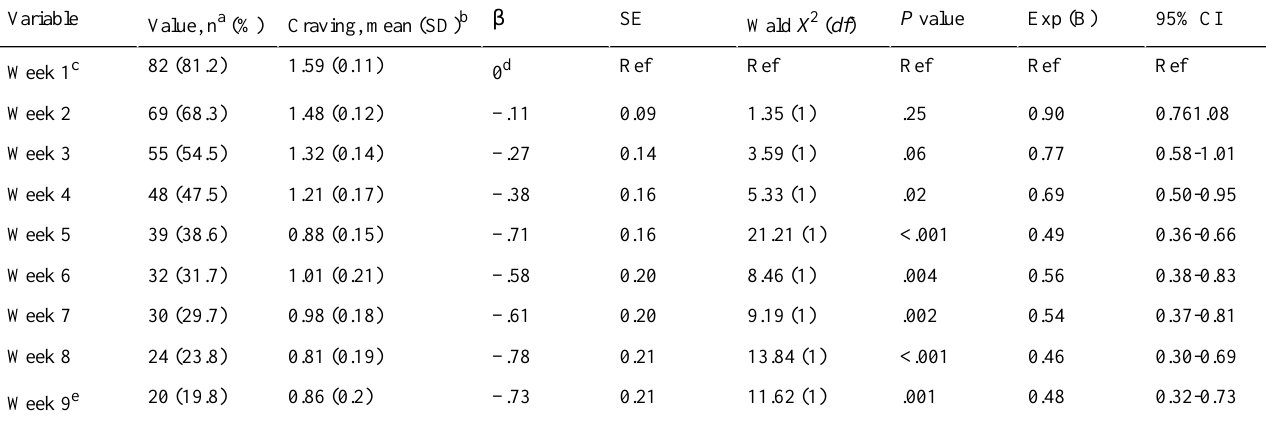
Table 2. Participants’ (N=101) craving ratings from week 1 to week 9 reported in the Woebot for the treatment of substance use disorders (W-SUDs)